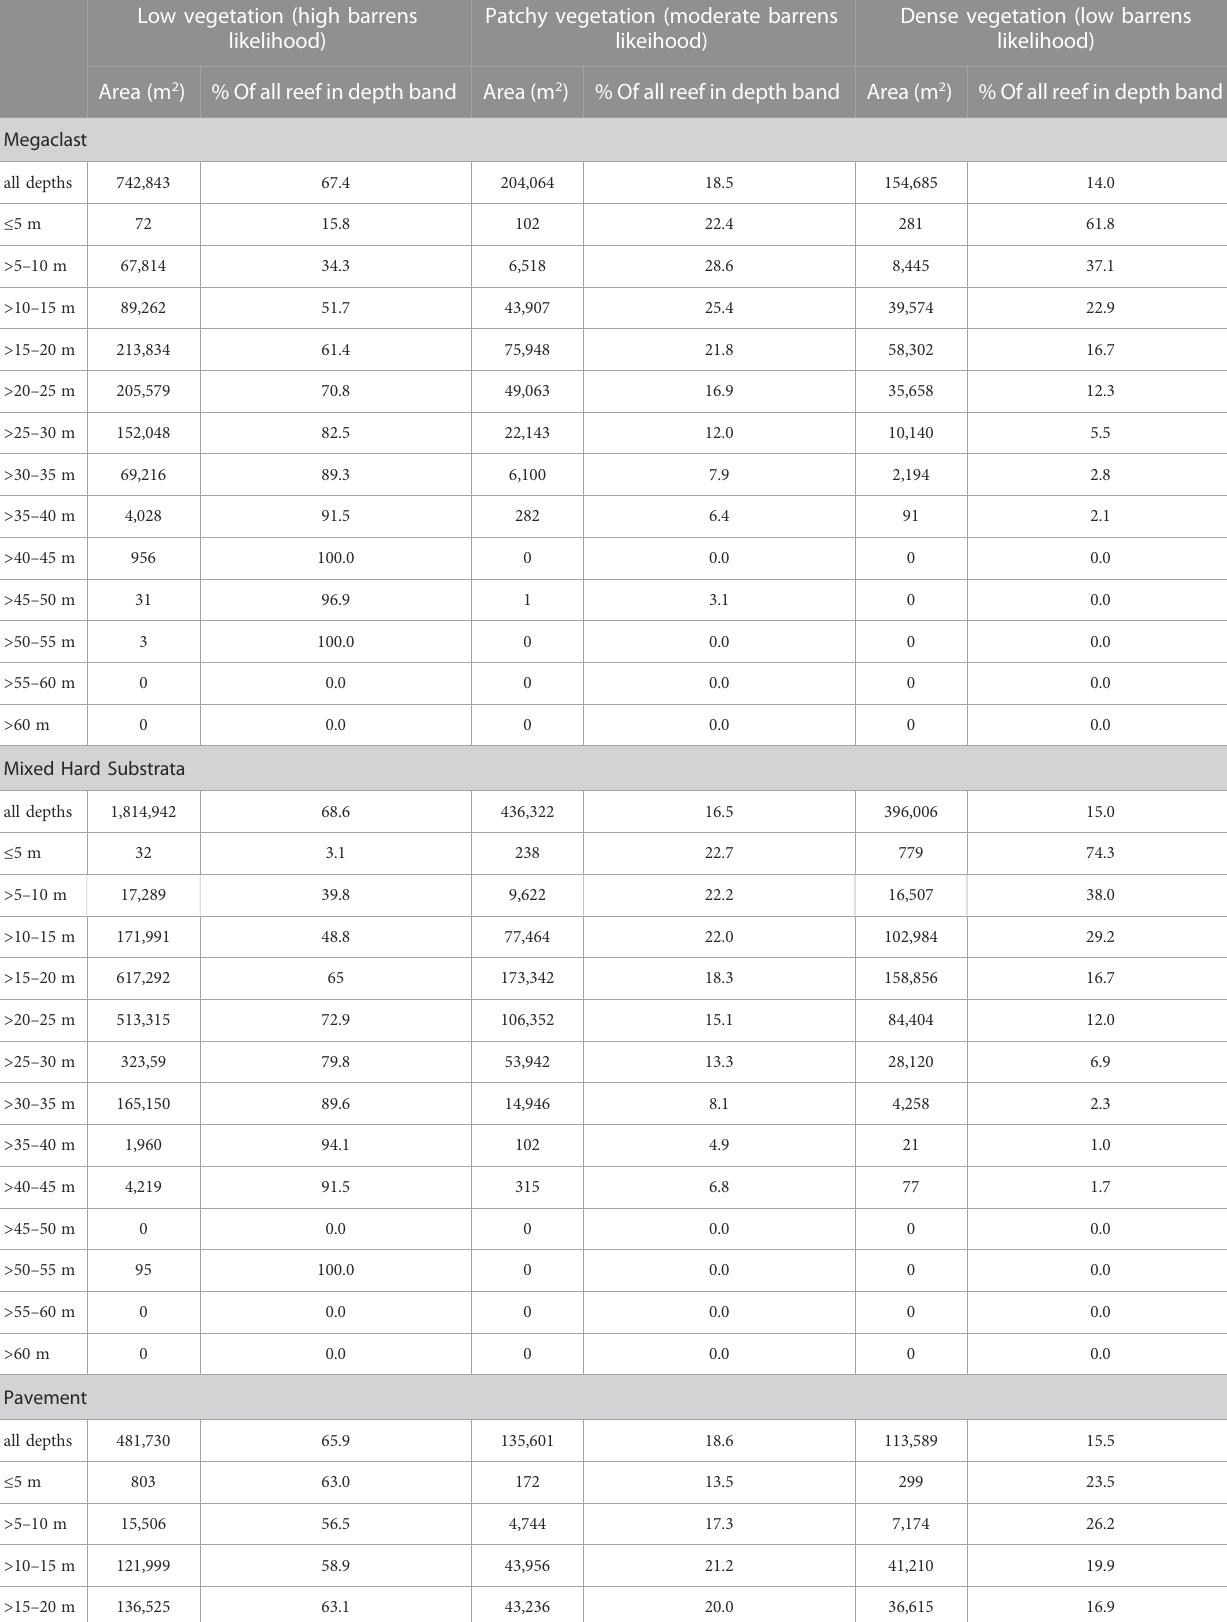
TABLE 5 Occurrence of barrens likelihood classes, by depth (5 m intervals) and hard substratum type (sand excluded). Low vegetation (high barrens Patchy vegetation (moderate barrens Dense vegetation (low barrens likelihood) likeihood)